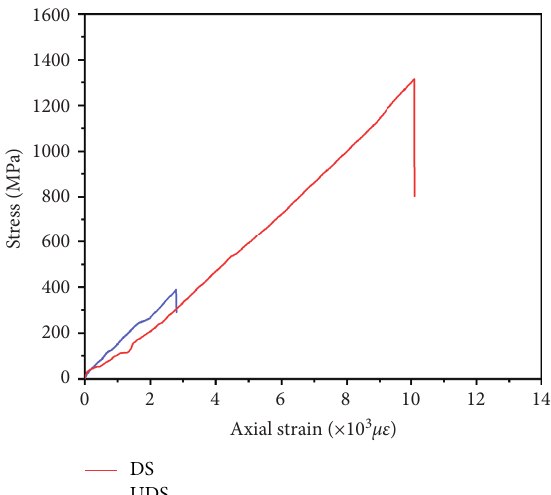
Figure 19: Average stress-strain curves of the CFRP rods anchored by dissolution-rebond anchor and traditional bond anchor.